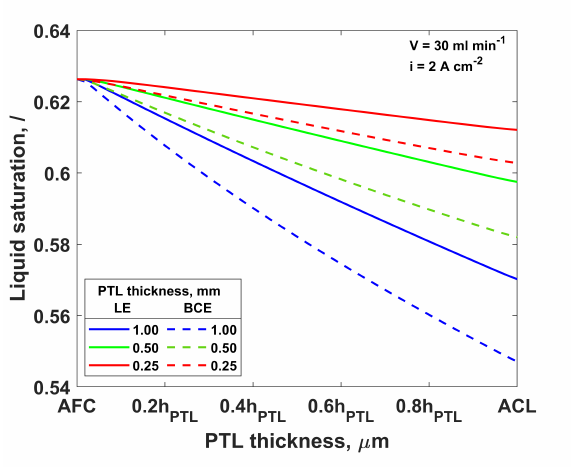
Figure 6. Liquid saturation through PTL2 thickness for different total thicknesses of the PTL2 at inlet flow rate 30 mL min − 1 and current density 2 A cm − 2 ; solid lines—LE simulation, dashed lines—BCE